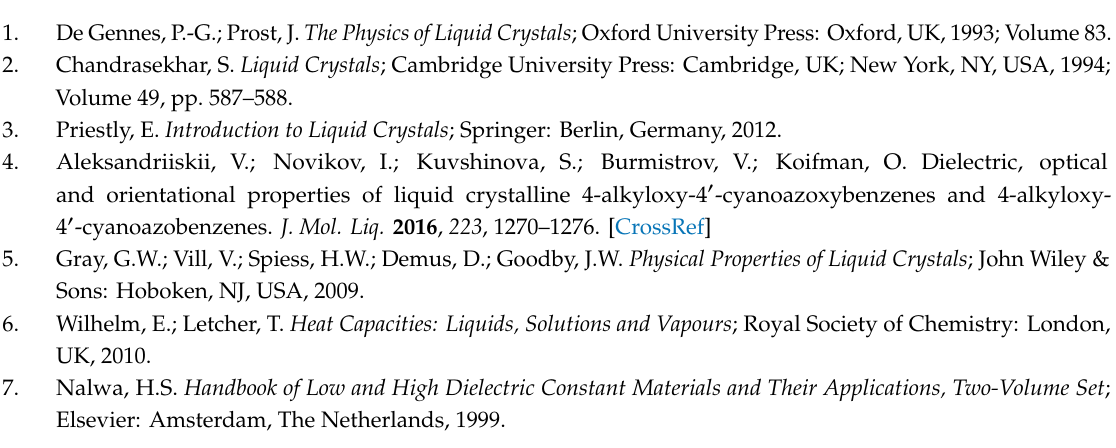
Figure S1: DSC thermograms of 1:1 SMHBCs (a) I / II and (b) I / III at heating rate 10 ◦ C / min upon heating and cooling